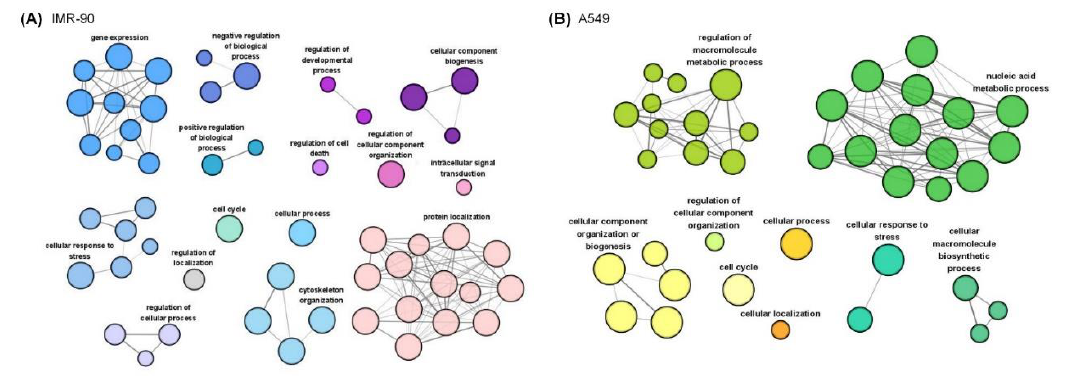
Figure 3. Network analysis of stretching-induced phosphorylation events. Phosphosites with a 1.5-fold change were analyzed with ClueGo ( A ). Network analysis of stretching-regulated phosphoproteins in IMR-90. ( B ). Network analysis of stretching-regulated phosphoproteins in A549.